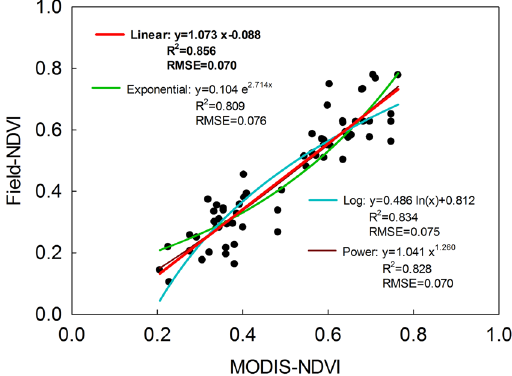
Figure 2. Regression models (linear, exponential, log, and power functions) of MODIS-NDVI and field- measured NDVI.